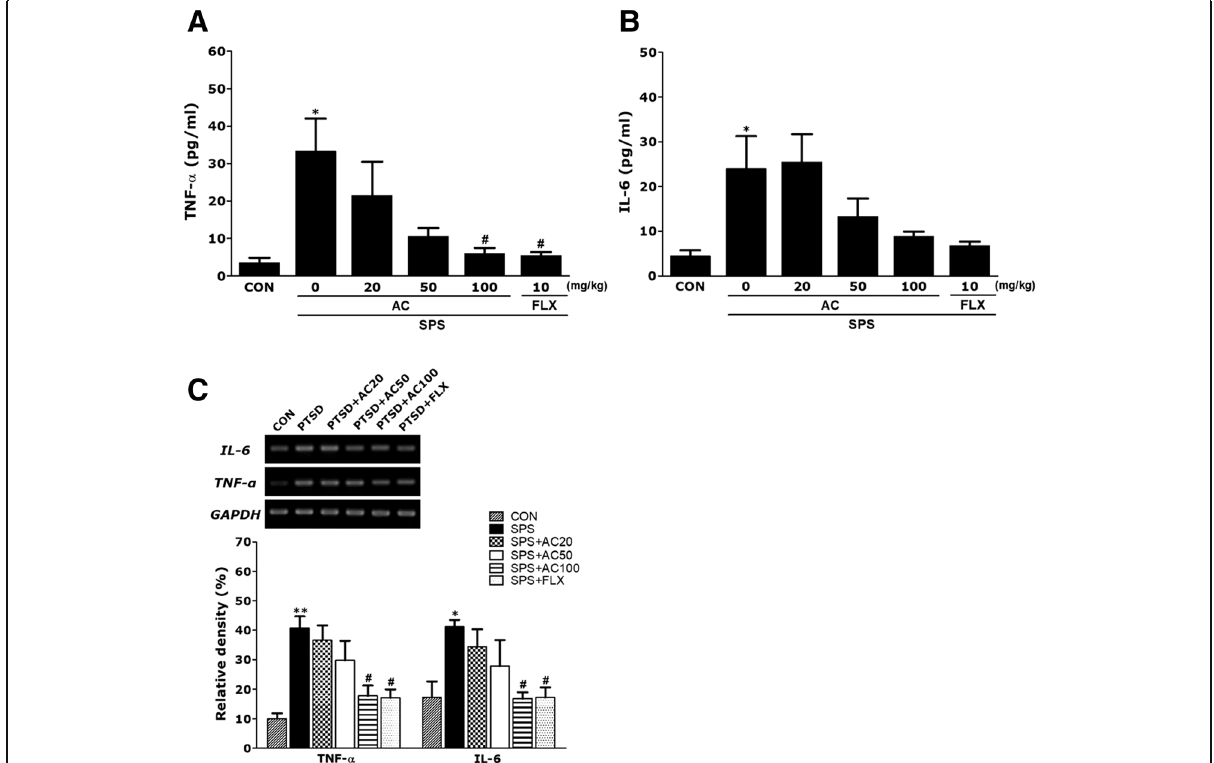
Fig. 6 Effects of AC on tumor necrosis factor- α (TNF- α ) and interleukin-6 (IL-6) protein levels ( a and b ) and mRNA expression levels in the hippocampus of rats with SPS-induced memory impairment. PCR bands on agarose gels and relative intensities are shown in ( c ). TNF- α and IL-6 mRNAs levels were normalized to GAPDH levels as an internal control ( n =4/group). * p <0.05, ** p <0.01 vs. the CON group, # p <0.05 vs. the SPS